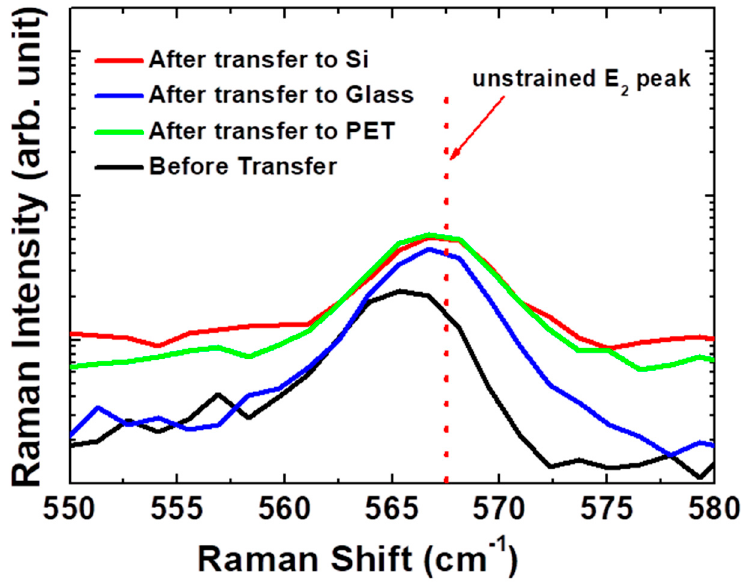
Figure 3. Raman spectra of GaN LEDs before and after transfer onto various substrates.